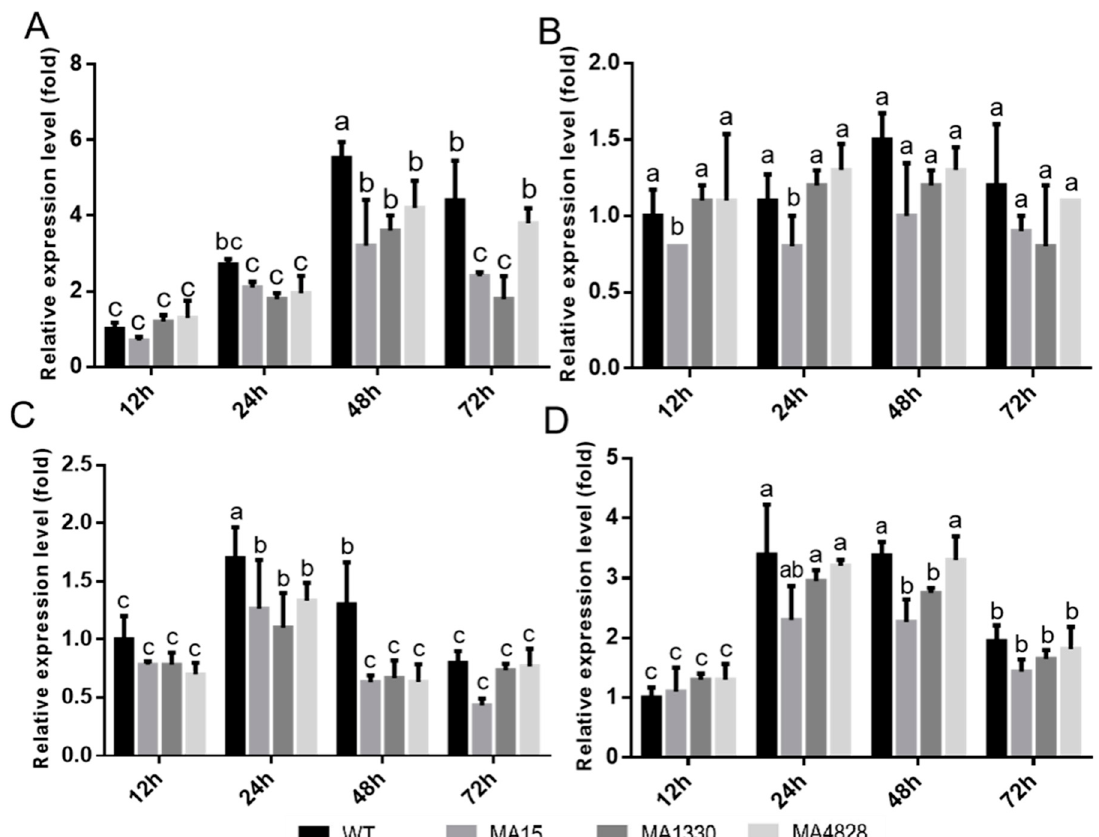
Figure 3. The biofilm-related gene expression of WT and mutants at 12 h, 24 h, 48 h, and 72 h. ( A ) The expression level of epsA involved in the synthesis of EPS; the main component of biofilm. ( B ) The expression level of tasA involved in the synthesis of extracellular protein; another vital component of biofilm. ( C ) The expression level of fliG involved in the movement of flagella, which contributes to swarming motility and biofilm formation. ( D ) The expression level of sfp involved in the synthesis of surfactin, which is related to inhibition against pathogen and biofilm formation. The expression of WT at 12 h was used as a control. Experiments were performed in triplicate with three biological replicates Different letters above the bars indicate significant differences ( p < 0.05).